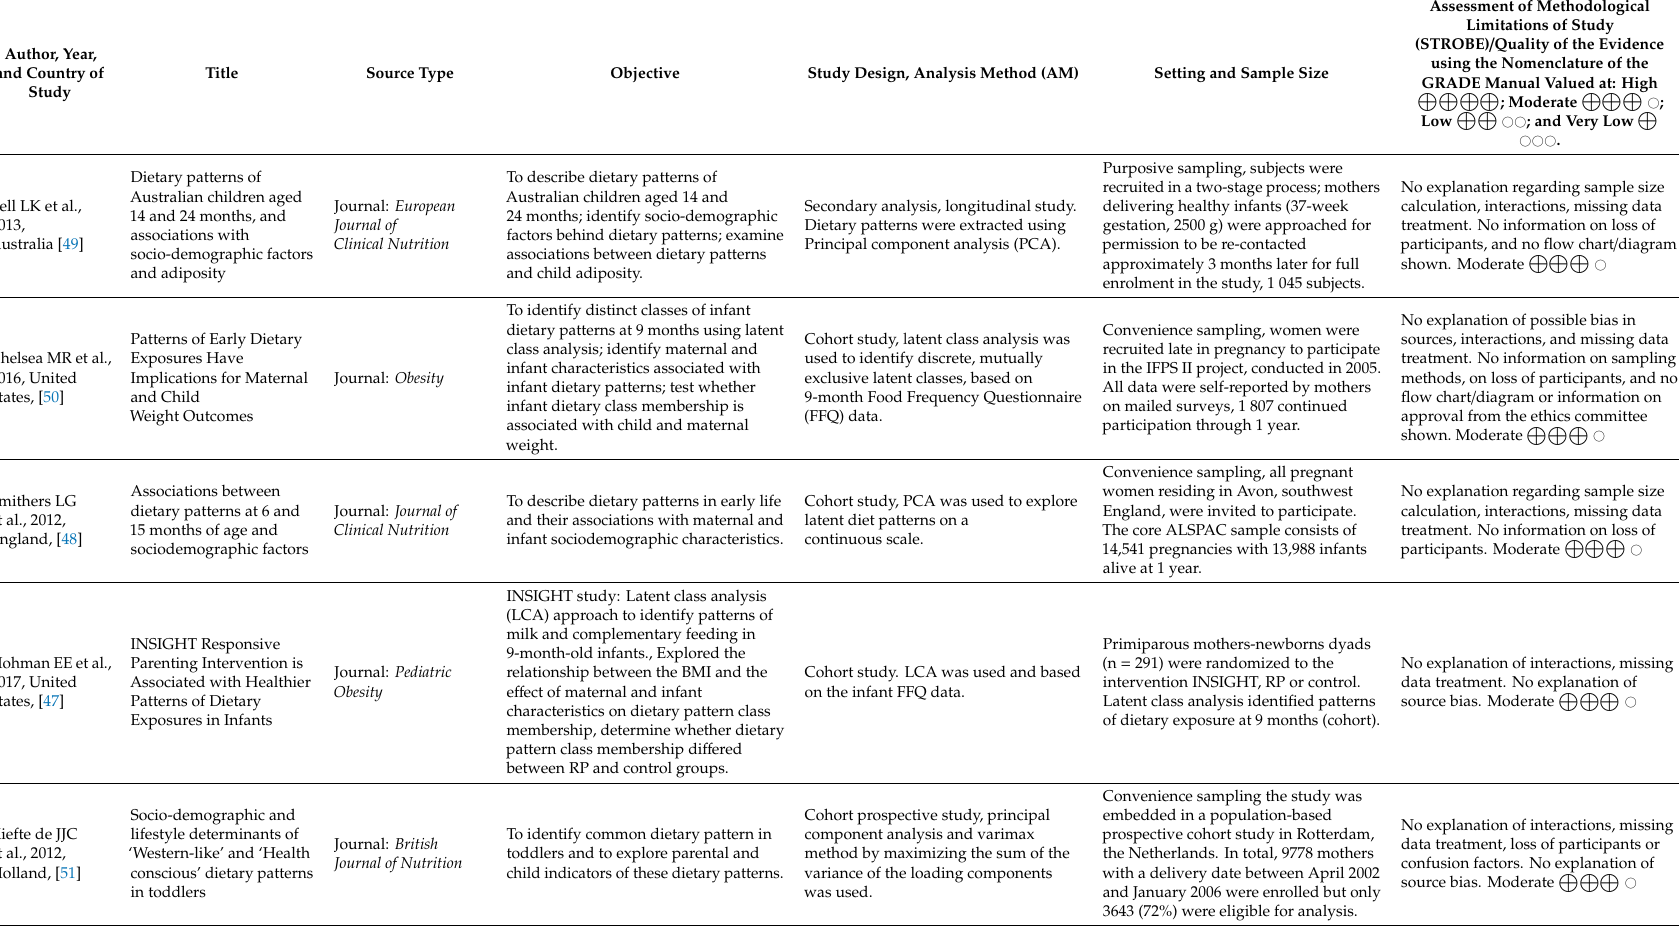
Table 3. Data extraction of studies included in review (title study details and assessment of methodological